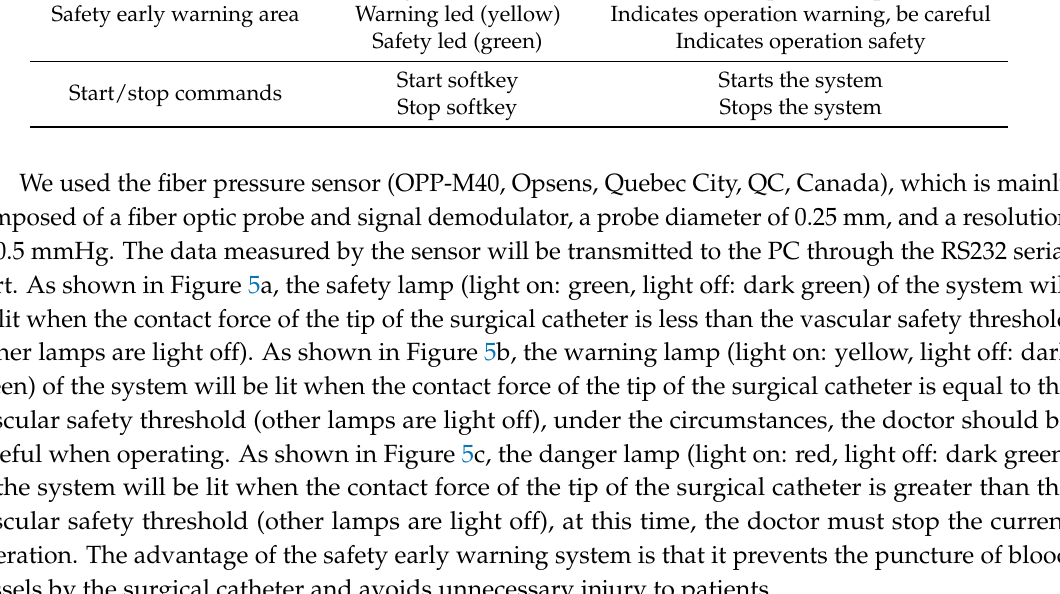
Table 1. Description of the operation safety early warning system